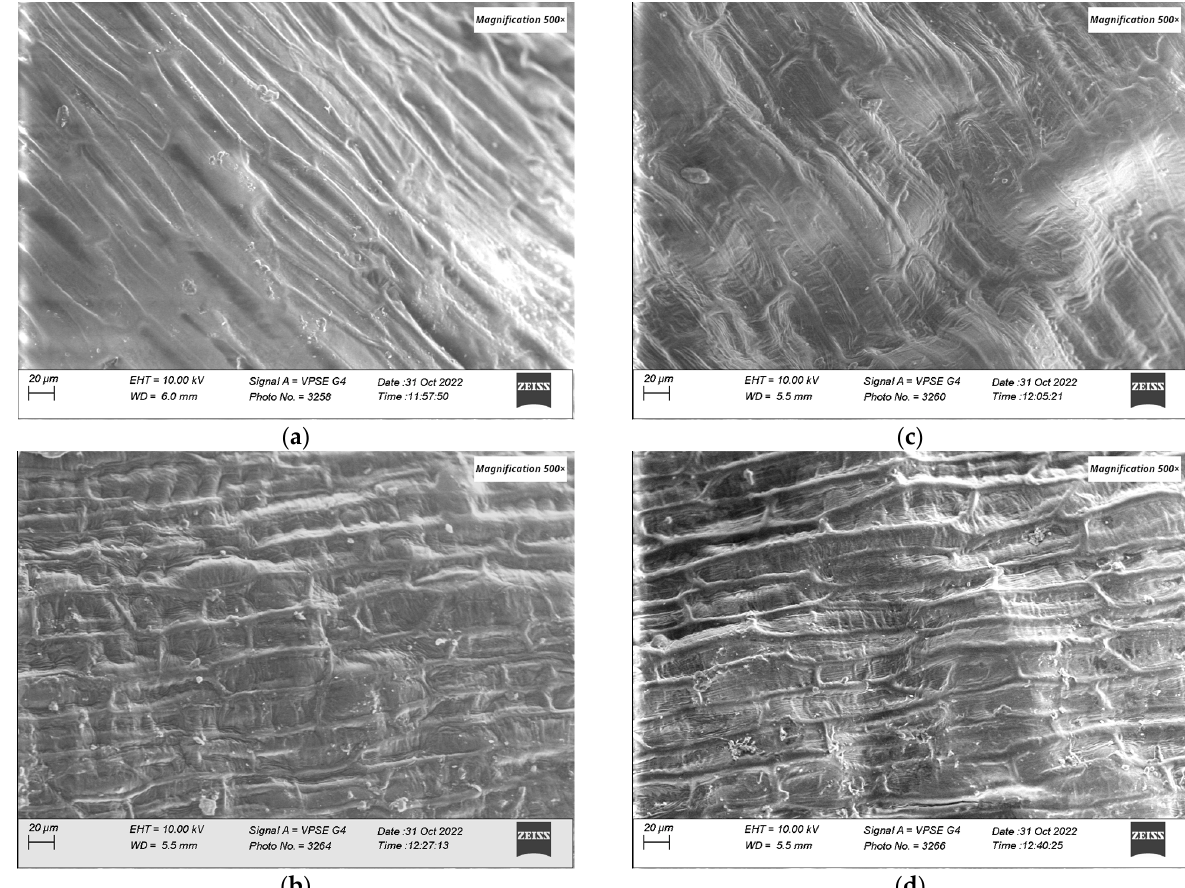
Figure 4. SEM images of control wheat seeds ( a , b ) (‘Otilia’/’Dacic’) and plasma-treated seeds ( c , d ) (‘Otilia’/’Dacic’); 500× magnification.